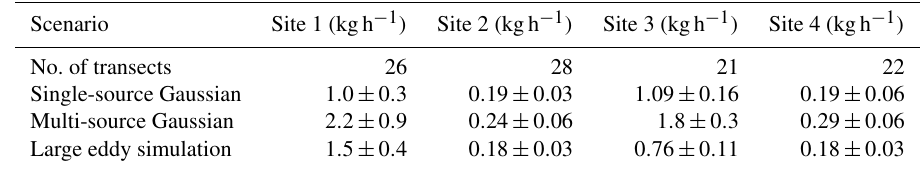
Figure 11. Comparison of three scenarios for Site 3 showing images through the downwind road plane ( ∼ 30m downwind as shown in Fig. 3) of (a) single-source Gaussian, (b) multi-source Gaussian and (c) averaged LES. The comparison of vertical distributions of (d) concentrations and (e) fluxes and of the horizontal distributions of (f) concentrations and (g) fluxes are also shown. The vertical LES flux corresponds to resolved fluxes only. Table 5. Comparison of mean emission rates using three scenarios from four sites ( ± 1 standard deviation of the